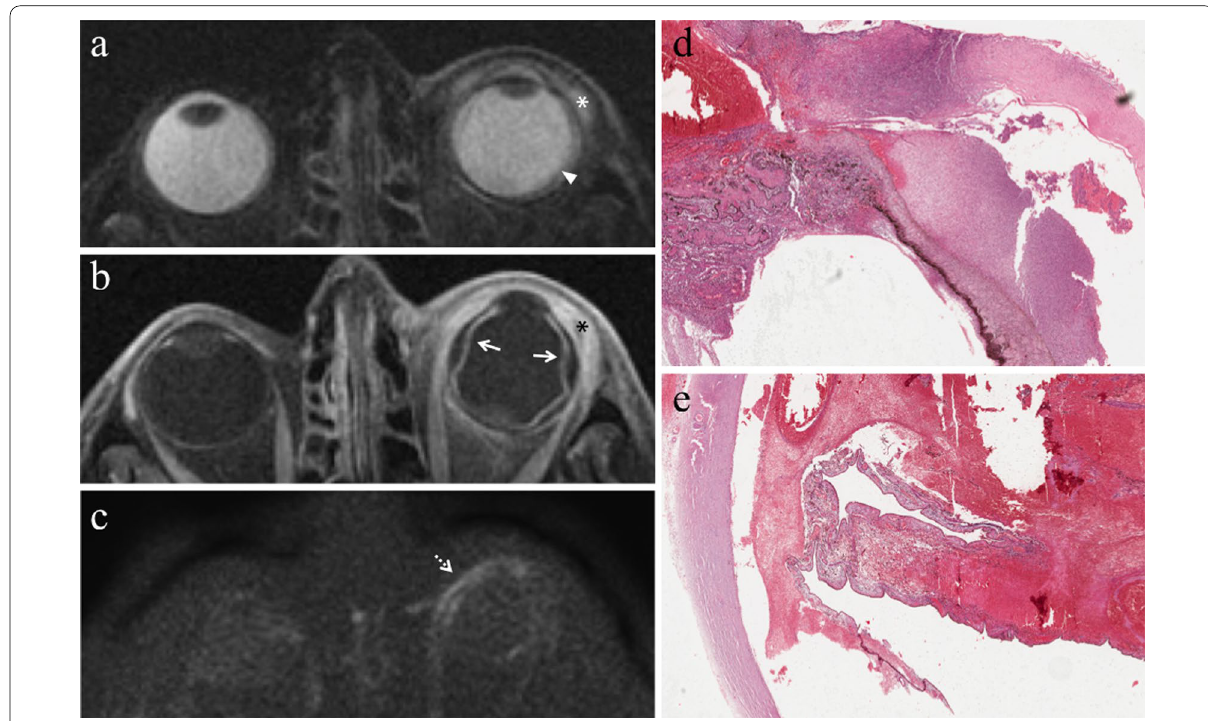
Fig. 8 A 72-year-old woman with radiation-induced panuveitis and diffuse choroidal detachment after proton-beam radiotherapy for uveal melanoma of the left eye. The patient underwent secondary enucleation four years after radiotherapic treatment because of radiation-related inflammatory complications. Axial ( a ) T2-weighted turbo spin-echo STIR and b contrast-enhanced fat-suppressed T1-weighted images. The choroid is diffusely thickened and detached and displays pronounced enhancement after contrast agent administration (white arrows in b ). On T2-weighted image, an exudative collection into the suprachoroidal space is detectable along the lateral aspect of the left eye (white arrowhead). Note the diffuse edematous thickening of the periocular tissues that appear hyperintense on T2-weighted image (white asterisk) and demonstrate marked enhancement on contrast-enhanced T1-weighted image (black asterisk). On c axial DW image (b 1000 s/mm 2 ), the periocular tissues and = detached choroid exhibit restricted diffusion with high signal intensity (white dotted arrow). d Medium magnification showing the histological equivalent of radiologically identified panuveitis: the suprachoroidal compartment is entirely replaced by an acute/suppurative inflammatory process, rich in neutrophils (H&E, original magnification 50 ). e Histopathology confirms the presence of a radiotherapy-related choroidal × detachment (H&E, original magnification 50 ×